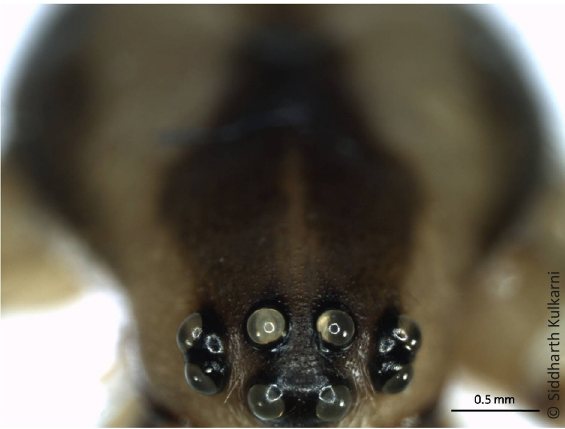
Image 2. Ocular region